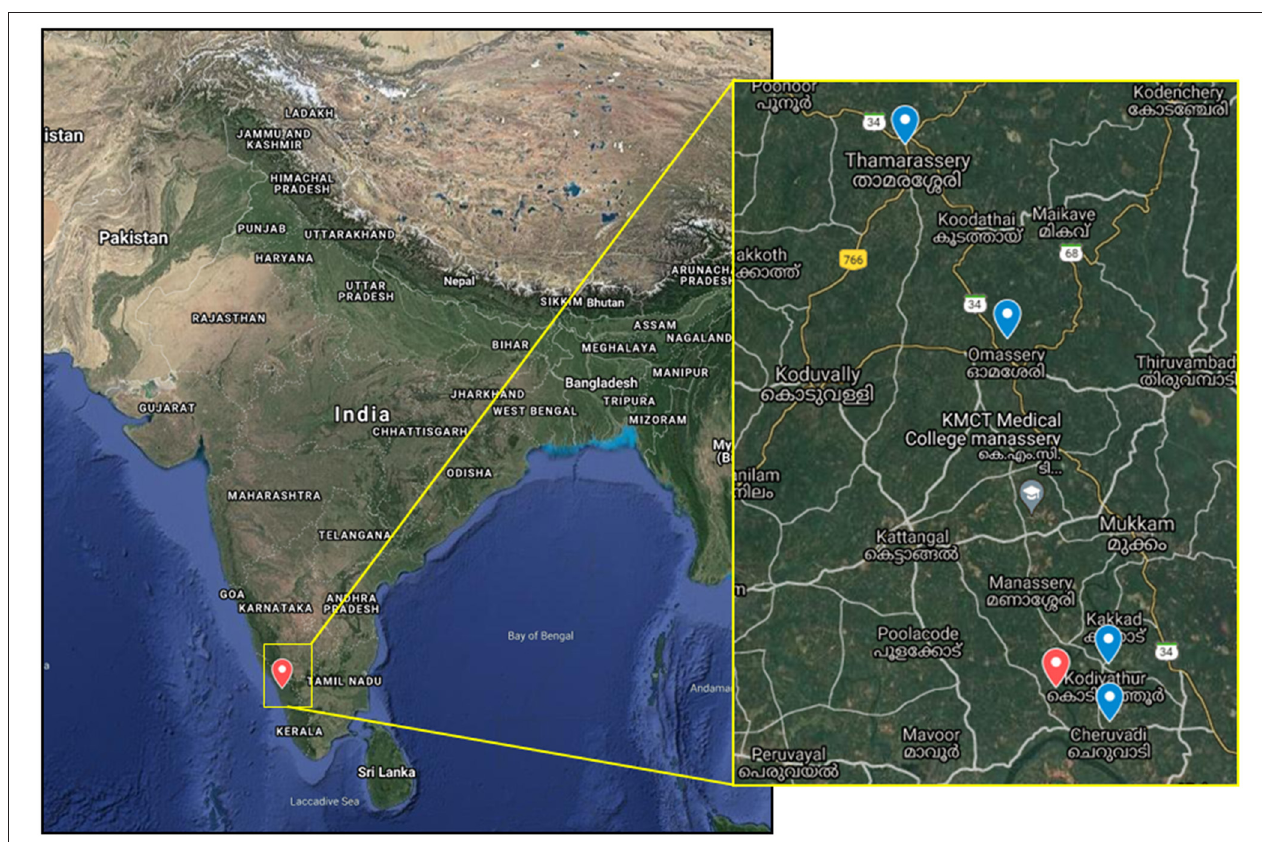
FIGURE 1 | The map shows the Nipah virus outbreak location in India and in the inset, the location of the index case house (red icon), and the four bat sampling sites (blue